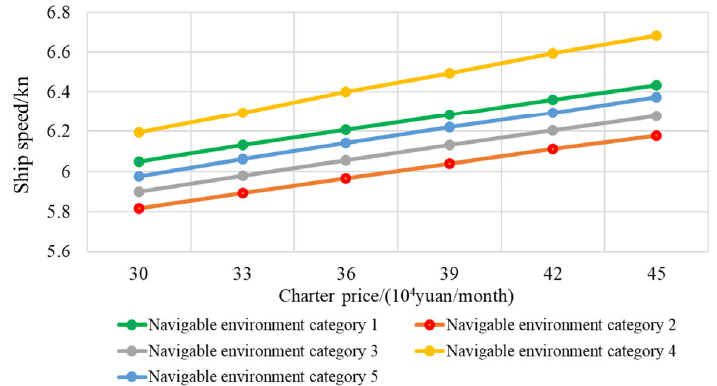
Figure 17. Optimal speeds for different environmental categories at different charter rates.